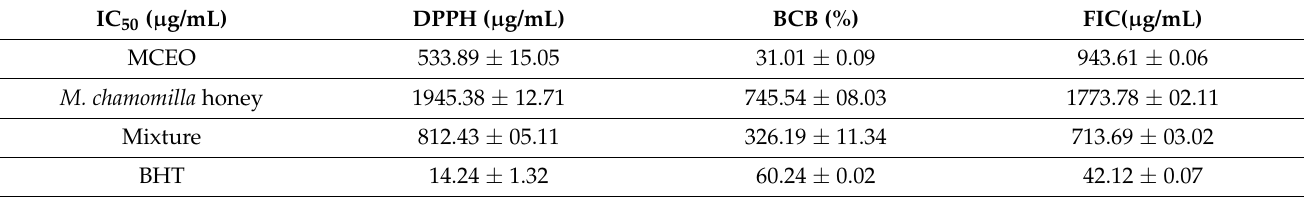
Table 3. Antioxidant effects of M. chamomilla honey, MCEO, and their mixture. IC 50 ( µ